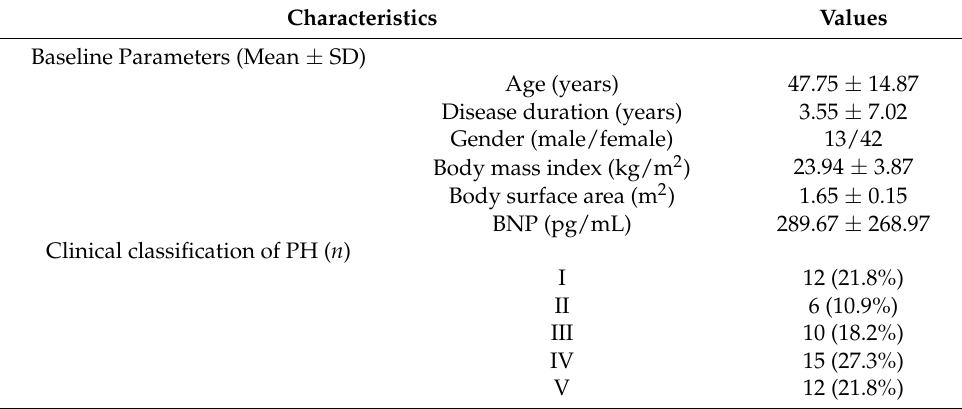
Table 1. Clinical and hemodynamic characteristics of patients with